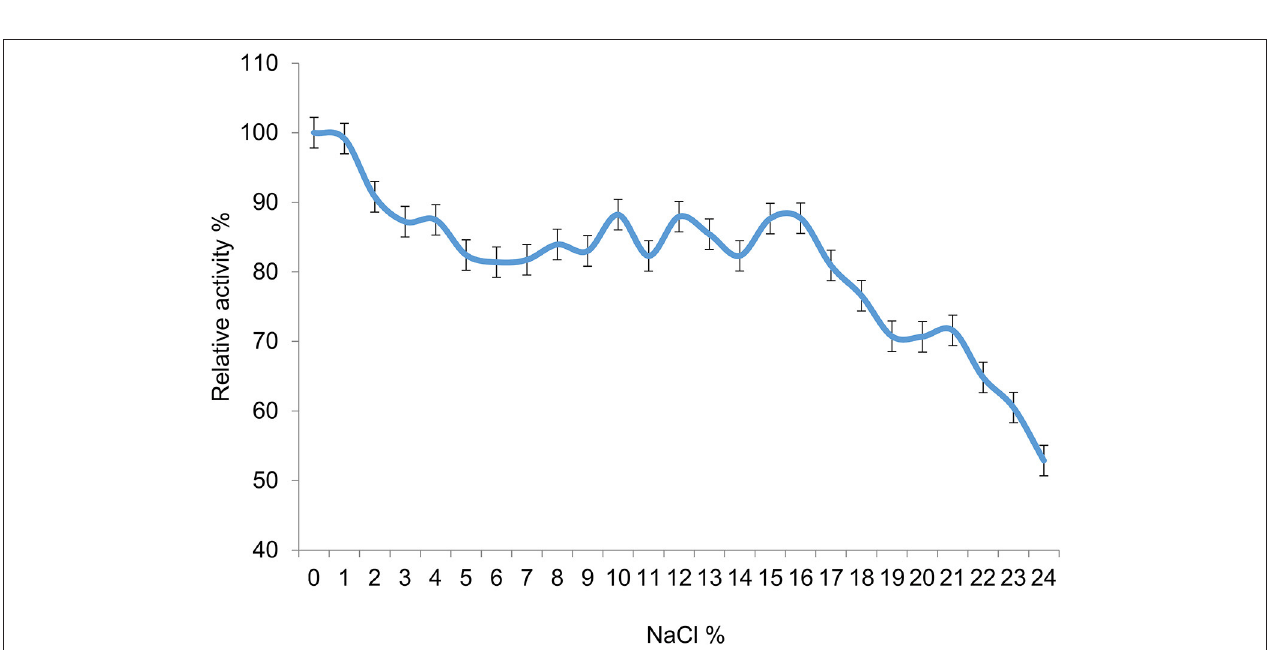
FIGURE 9 | Halotolerance of the 7N9 esterase activity. Sodium chloride concentrations ranging from 1 to 24% were tested for their effect on the activity of the 7N9 esterase. The values displayed are the means and standard deviations of triplicate measurements.